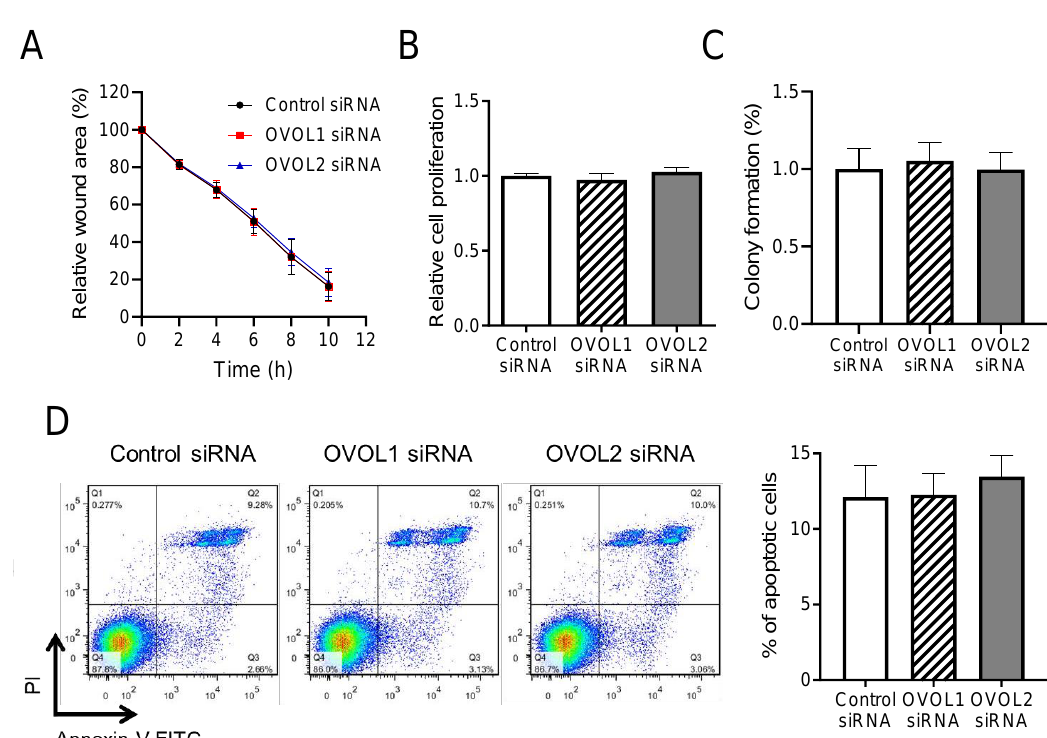
Figure 6. OVOL1/2 do not regulate wound healing, proliferation, colony formation, or apoptosis in a human SCC cell line. ( A ) A431 cells were transfected with control siRNA, OVOL1 siRNA, or OVOL2 siRNA and submitted to a wound healing assay. Forty-eight hours post-transfection, cell monolayers were scratched and tracked for cell migration until 10 h post-scratching. A representative result is shown. ( B ) Cell proliferation was examined in siRNA-transfected cells using the WST-1 assay 48 h post-transfection. ( C ) The colony-forming ability of siRNA-transfected cells was assessed using the semi-solid agar and MTT assay. ( D ) The apoptotic status of siRNA-transfected cells was evaluated by propidium iodide–Annexin V staining and measured by flow cytometry. (Left) Representative flow cytometric images and (right) the percentages of apoptotic cells in all populations. Mann–Whitney U -test; error bars represent mean ± standard deviation. p -values < 0.05 were assumed to indicate a statistically significant difference. All of the experiments were independently repeated at least three times.